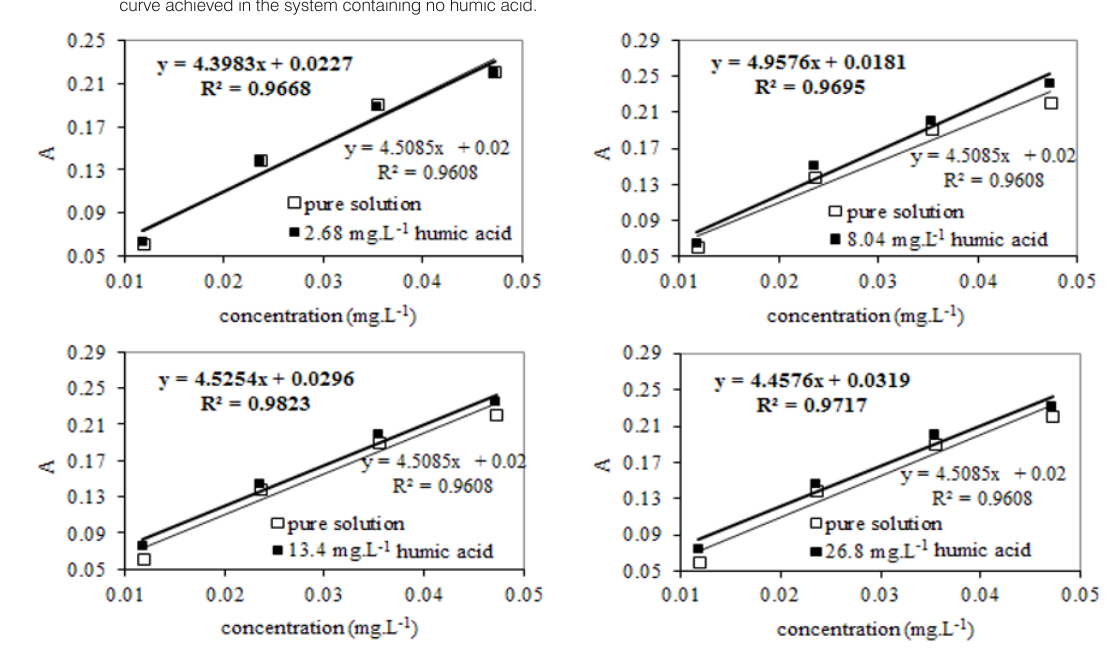
Figure 8. Calibration curves for Novanik 1047A: comparison of curve measured in presence of particular humic acid concentration (where absorbances were lowered about absorbance of humic acid solution with the same concentration, see Table 1) with the calibration curve achieved in the system containing no humic